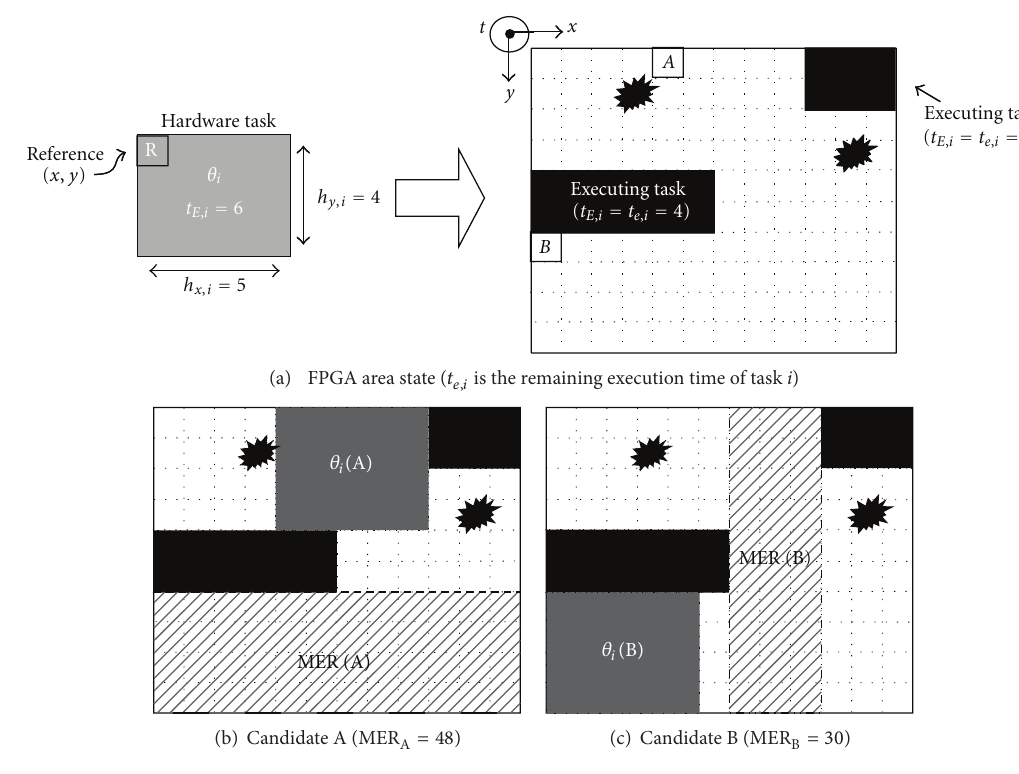
Figure 7: Allocating 𝜃 𝑖 at candidate positions A and B.